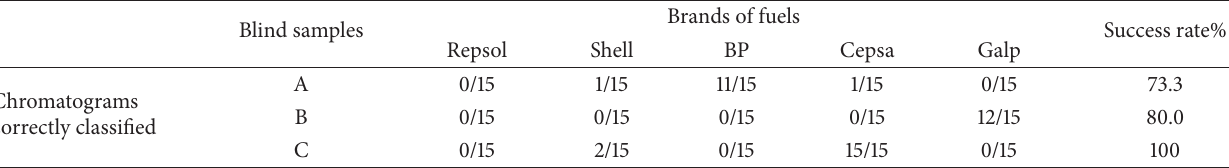
Table 1: Neural networks classification results for blind